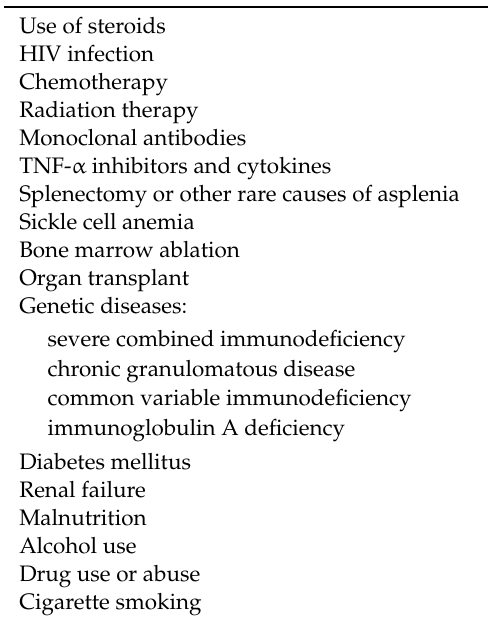
Table 2. Risk factors for pre-conceptional immune suppression excluded for both patients of our